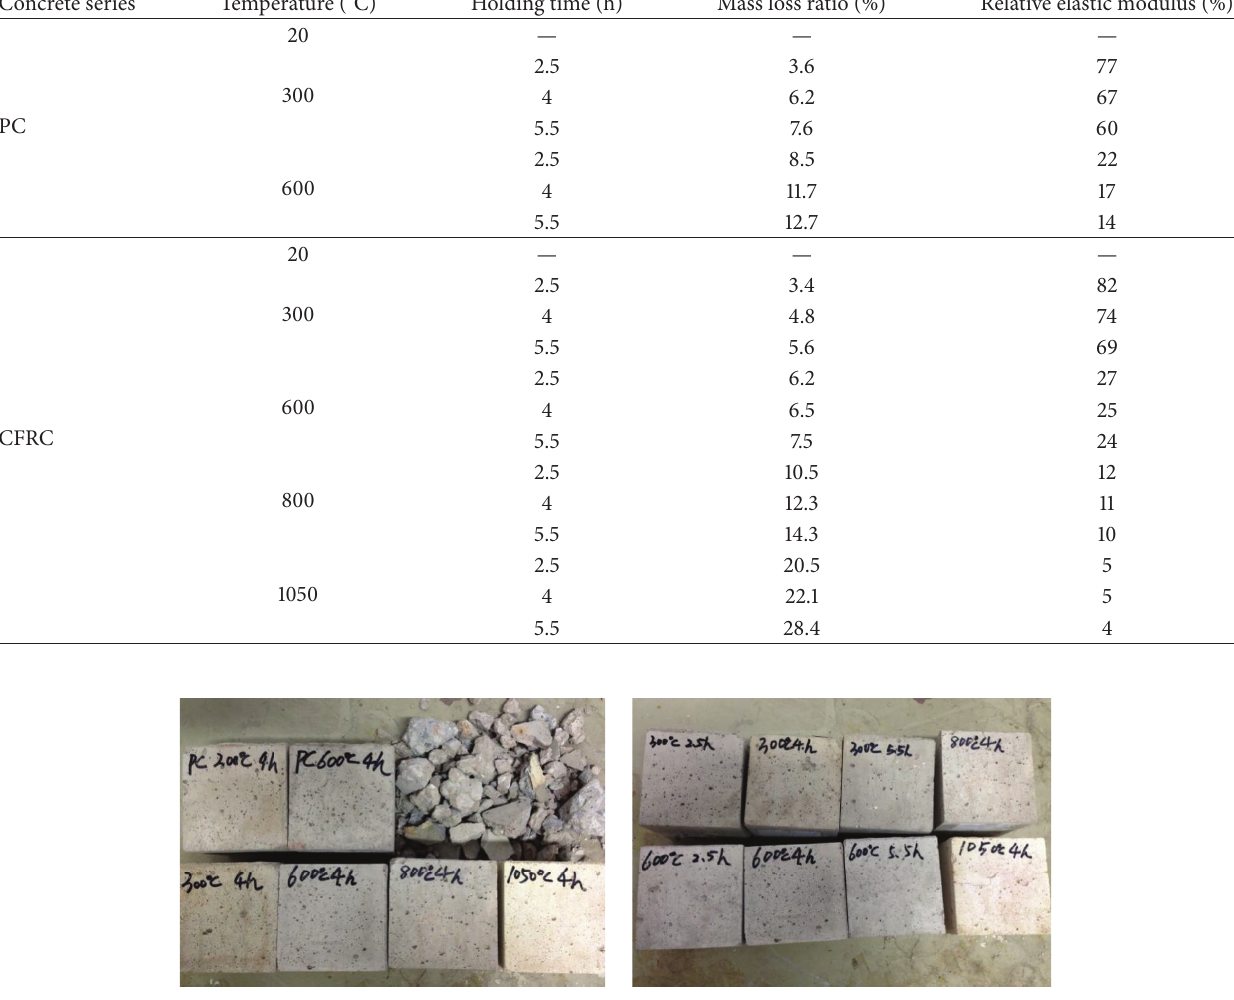
Table 4: Influence of high temperatures on physical properties of concrete.